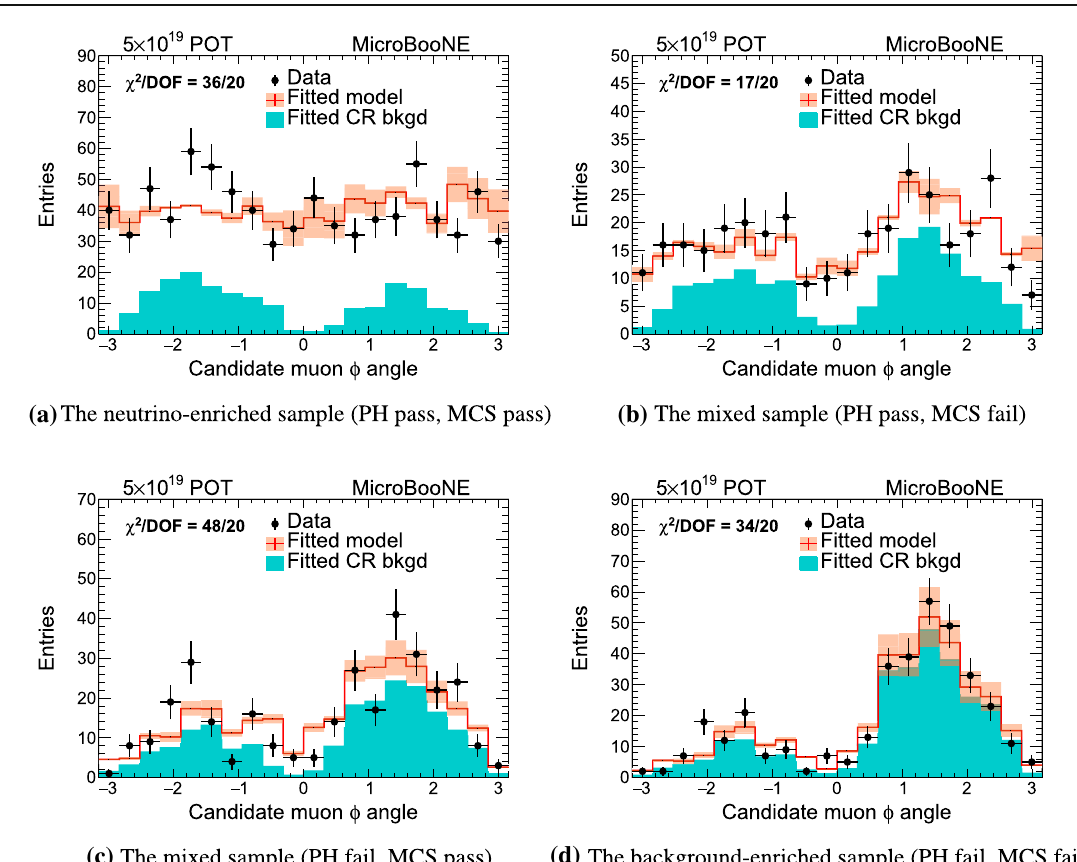
Fig. 13 Candidate muon azimuthal angle distribution from the full selected sample for data and GENIE default MC. The neutrino-enriched sample is nearly flat as expected. The CR-background-enriched sample has expected peaks at ± π/